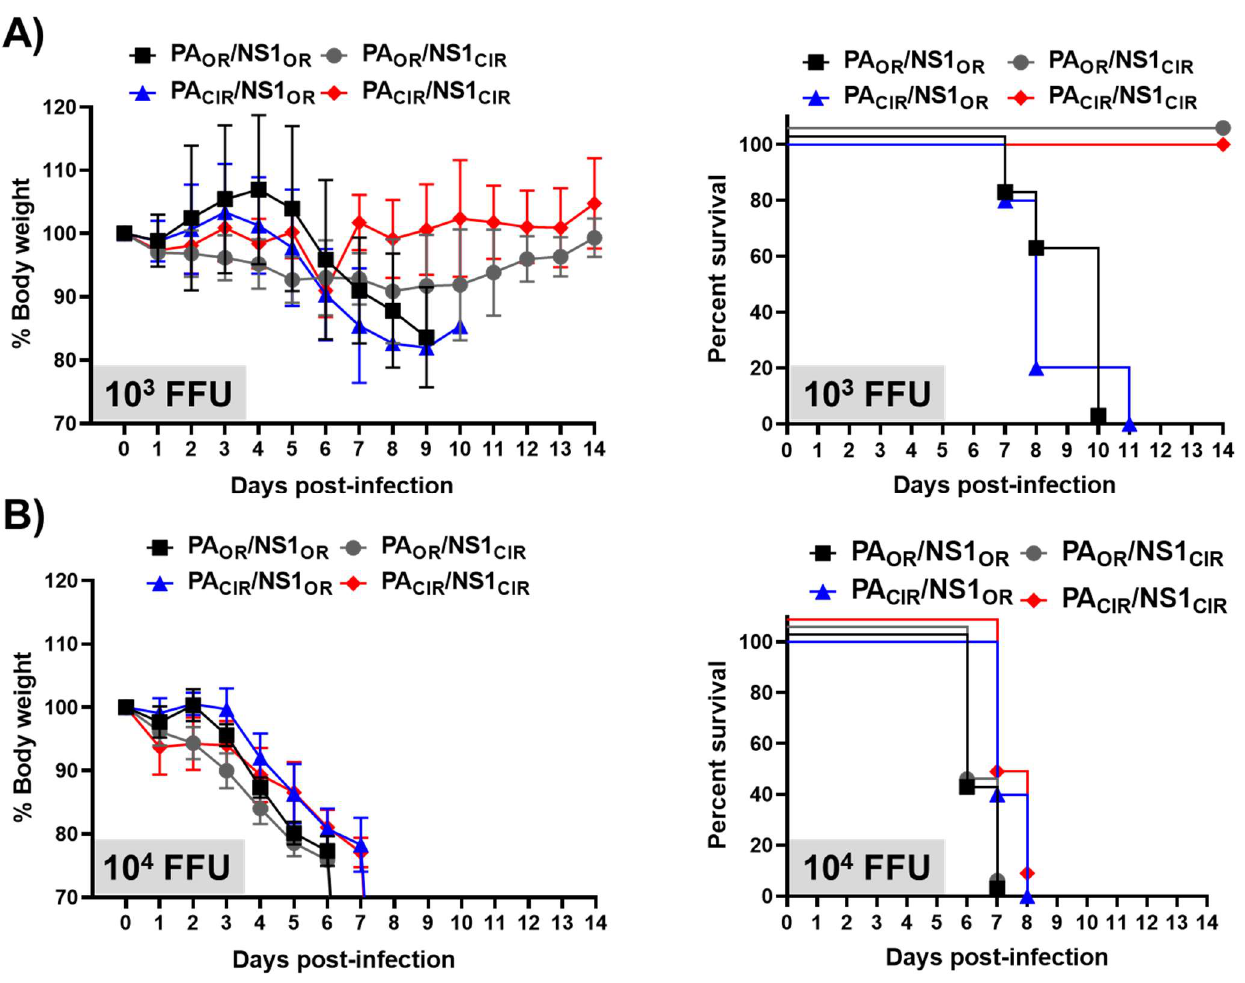
Figure 6. Virulence of recombinant viruses containing amino acid changes in H5N1 NS1 and PA proteins: Groups of 7-to-8-week-old A129 female mice ( N = 5/group) were infected with 1000 (10 3 ; A ) or 10,000 (10 4 ; B ) FFU/mouse of the recombinant viruses encoding the indicated H5N1 NS1 and PA proteins (PA OR /NS1 OR , PA OR /NS1 CIR , PA CIR /NS1 OR , PA CIR /NS1 CIR ). Weight loss (left panels) and survival (right panels) were evaluated daily for 2 weeks.